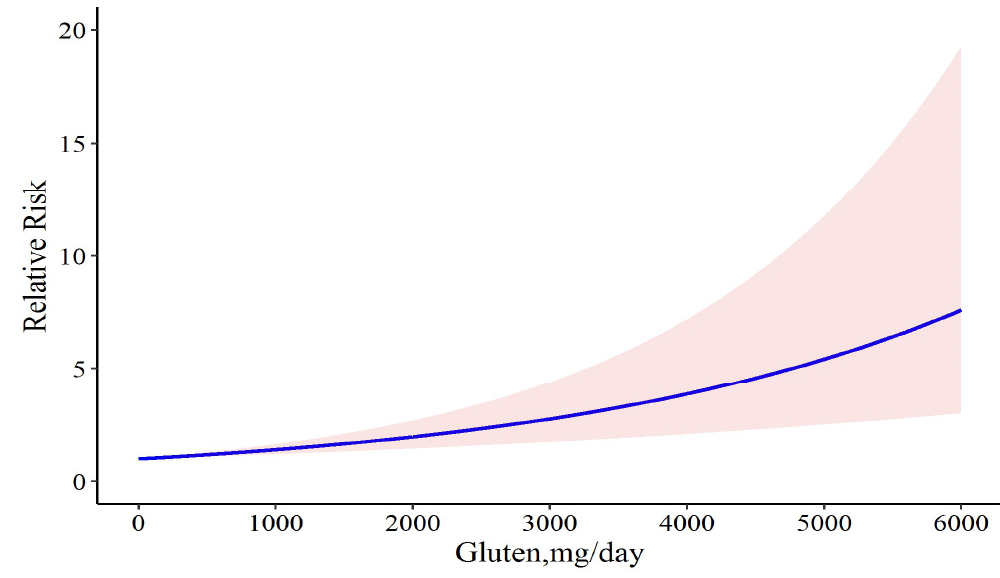
Figure 4. The dose-response meta-analysis of gluten dose and risk of CD relapse following sensitivity analysis. The solid curve and the shadow area indicate the relative risk with a corresponding 95% confidence interval.